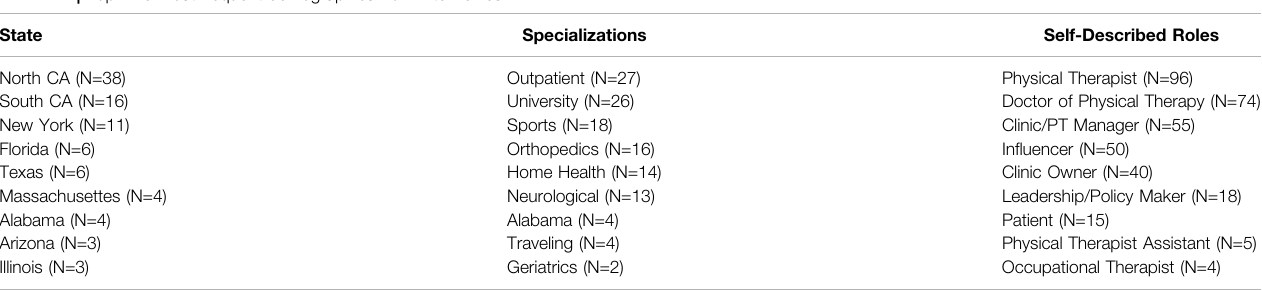
Frontiers in Virtual Reality |